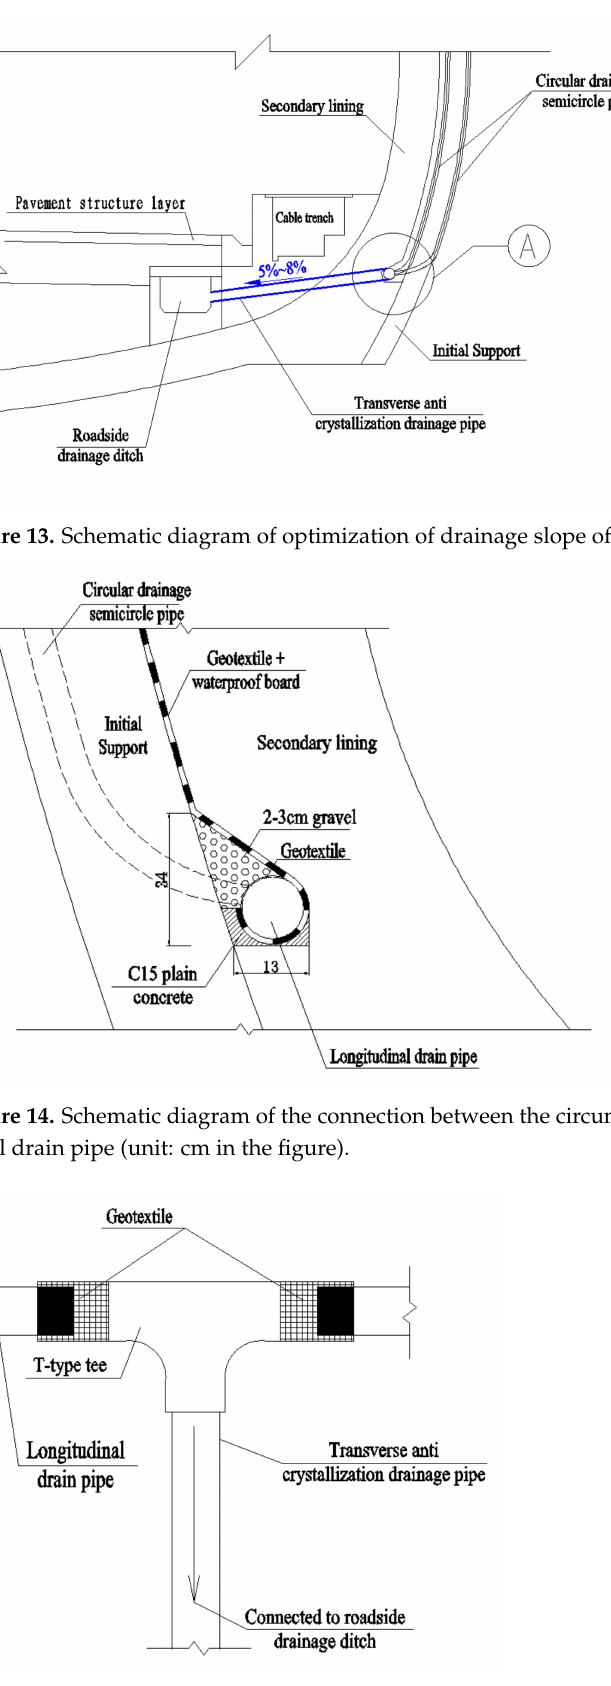
Figure 15. Connection diagram of longitudinal drainage pipe and transverse anti-crystallization drainage